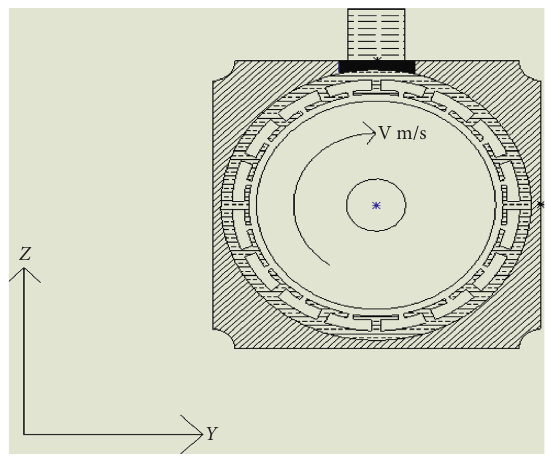
Figure 1: Servo motor working